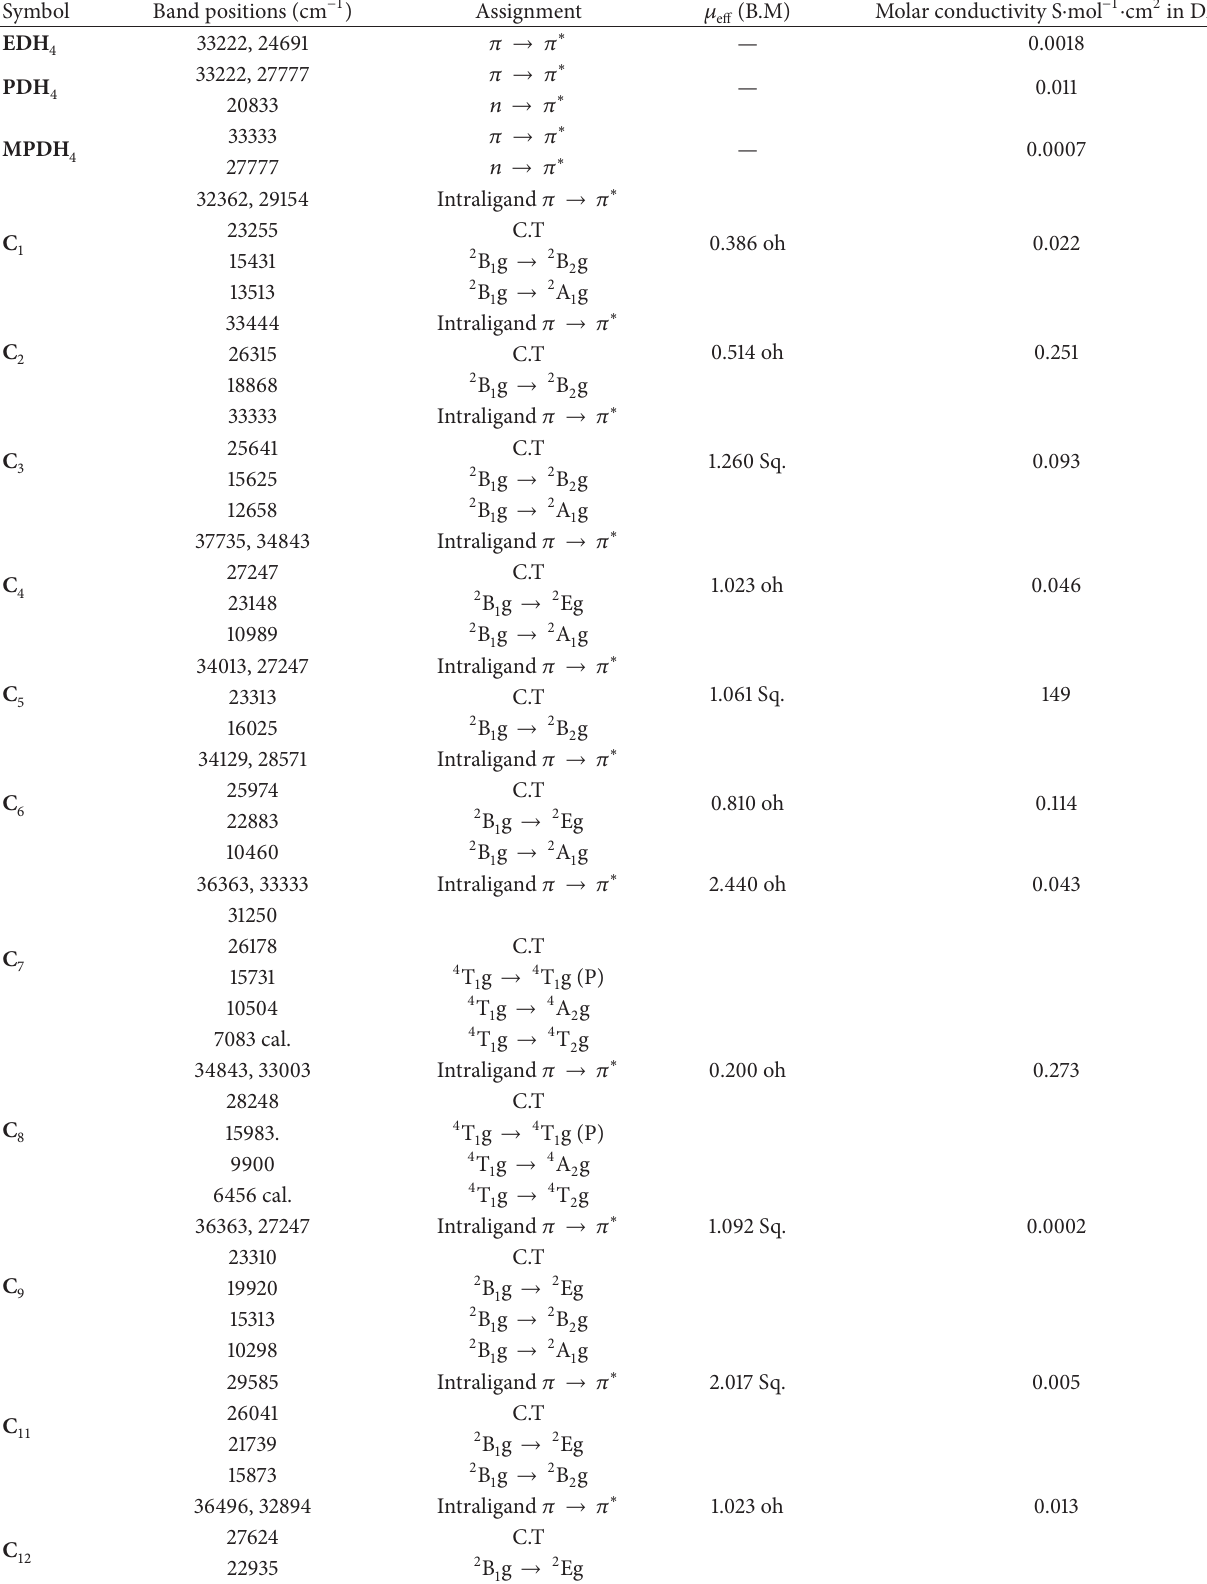
Table 5: Electronic spectra, magnetic moments, and molar conductivity data of Schiff bases and their metal complexes. Symbol Band positions (cm −1